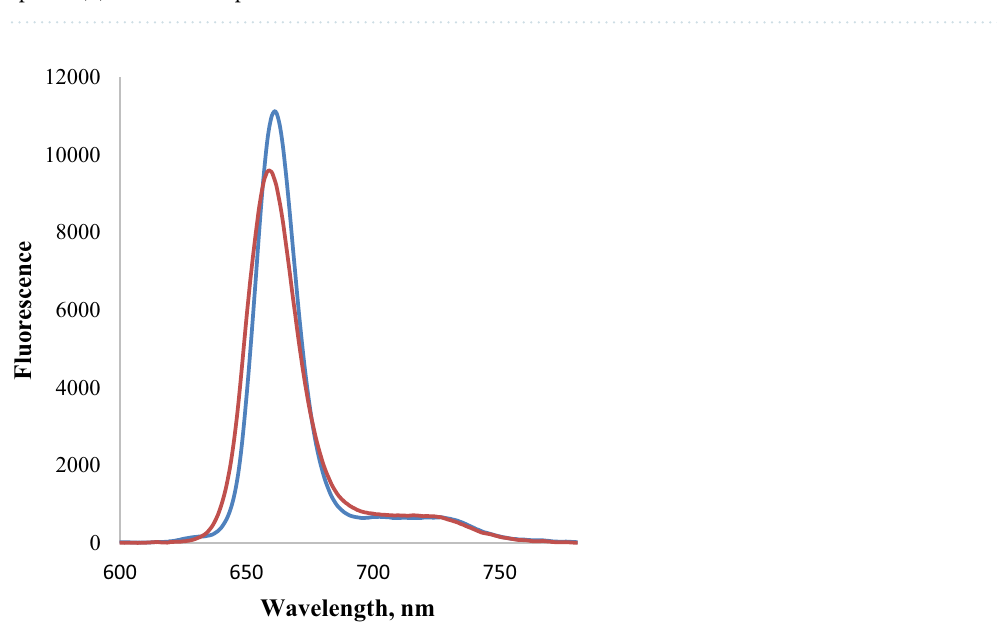
Figure 5. Direct titration of chlorin (1·10 −6 M) by ORF3a protein (1·10 −7 ÷ 1·10 −6 M) in PBS: ( a ) UV–Vis spectra ( b ) fluorescence spectra.